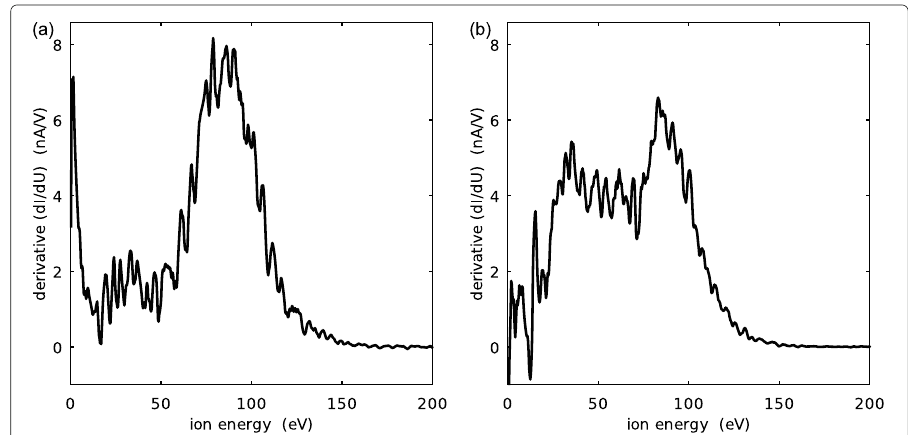
Fig. 15 RPA measurements with the two sensors in the secondary plasma of a HEMPT. The two plots show quasi-simultaneous measurements with (a) the engineering model and (b) the demonstrator model. The aquisition time was 9.4s